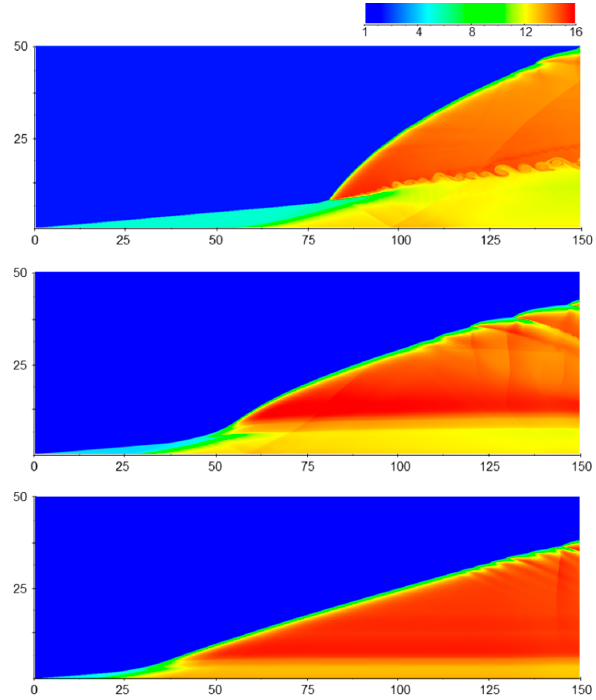
Figure 10. Temperature contours with k R = 2.5 and θ = 30 ◦ for M 0 = 9.0 (upper); 10.0 (middle); and 11.0 (lower).